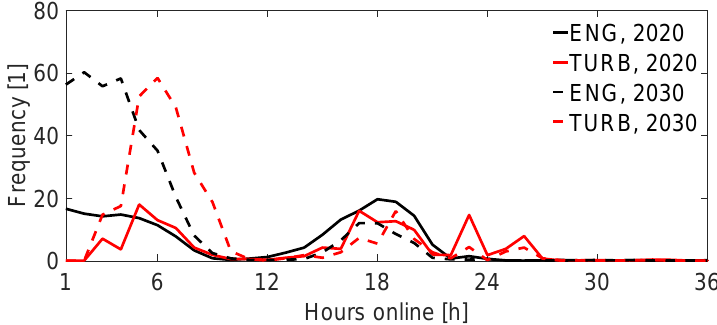
Figure 6. Online time distributions of CCGE and CCGT for energy-only cases in 2020 and